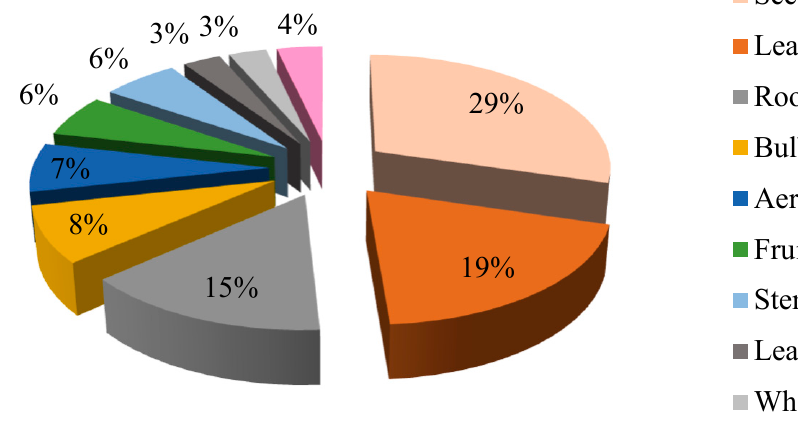
Figure 2. Percentage of the different parts.